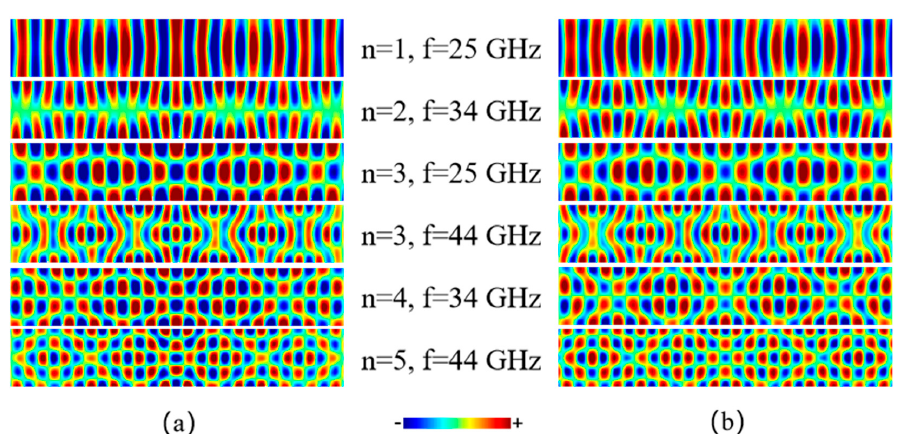
Figure 2. ( a ) SW patterns extracted from simulations when excited by using local fields oscillating with a particular frequency f . Each local field has a specially designed spatial distribution to couple maximally to a mode with a certain order number as indicated by n . These patterns are clearly more complex than regular standing waves along the width direction. ( b ) Wave patterns reconstructed artificially by superposing several degenerate eigen modes with different order numbers, demonstrating the branch hybridization effect taking place in simulations.